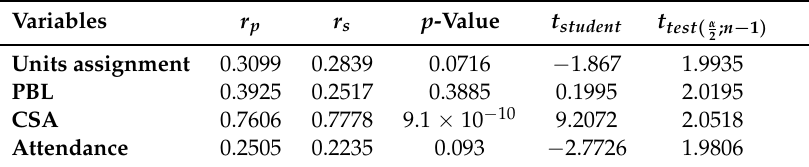
Table 7. Correlation and t student test between the grades obtained by students and the use of units assignments; PBL sessions; CSA; sessions’